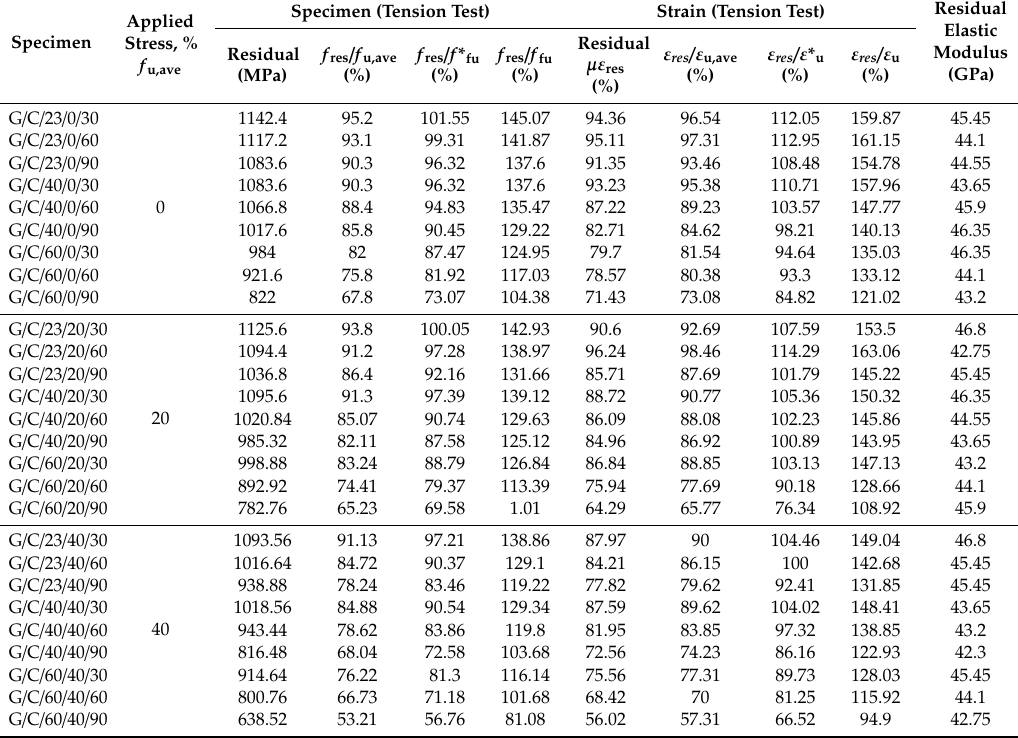
Table 5. Experimental tensile properties of conditioned GFRP specimens exposed to concrete pore